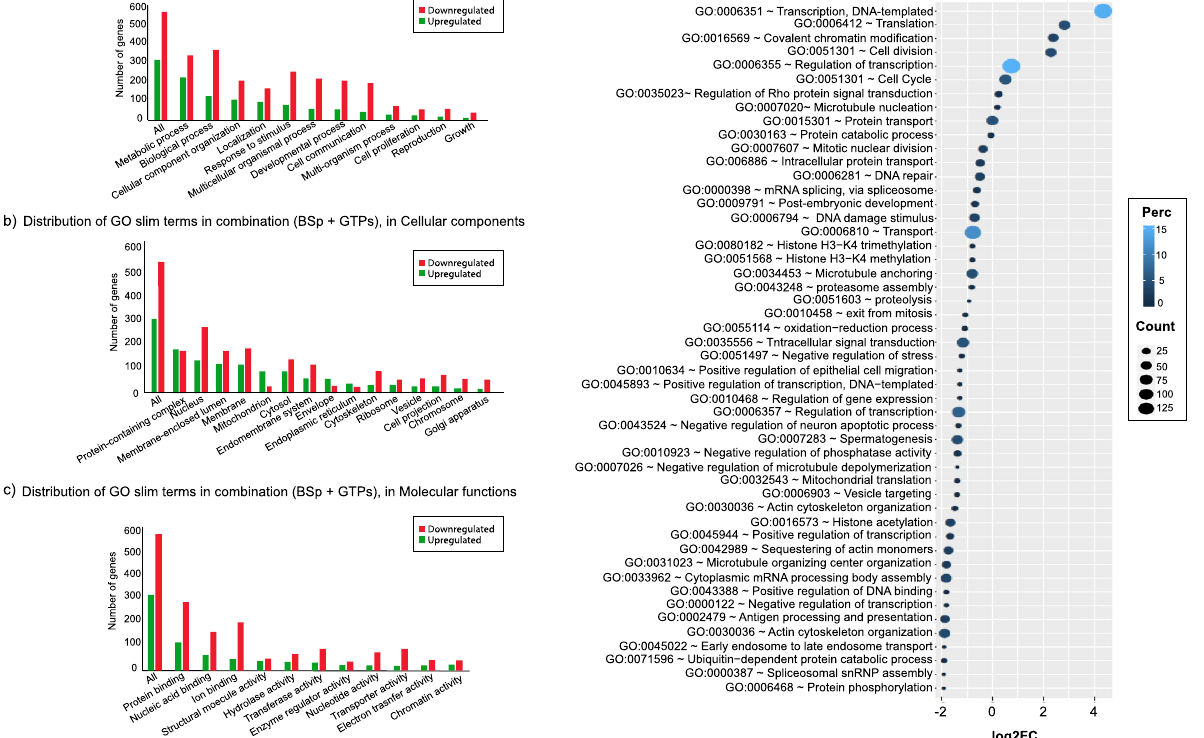
Figure 4. Bar plot distribution of GO slim terms of differentially expressed transcripts related to the combination (BSp + GTPs) treatment group in ( a ) biological process, ( b ) cellular components and ( c ) molecular functions wherein red bars represent downregulated genes and green bars represent up-regulated genes. The height in the bar plot represents the total number of differentially expressed genes. ( d ) Gene ontology enrichment terms and REACTOME pathways analyses using DAVID web-based tool. The plot is sorted based on decreasing FC wherein Y-axis represents specific GO terms related to biological pathways and X-axis represents log 10 (FC) associated with each GO